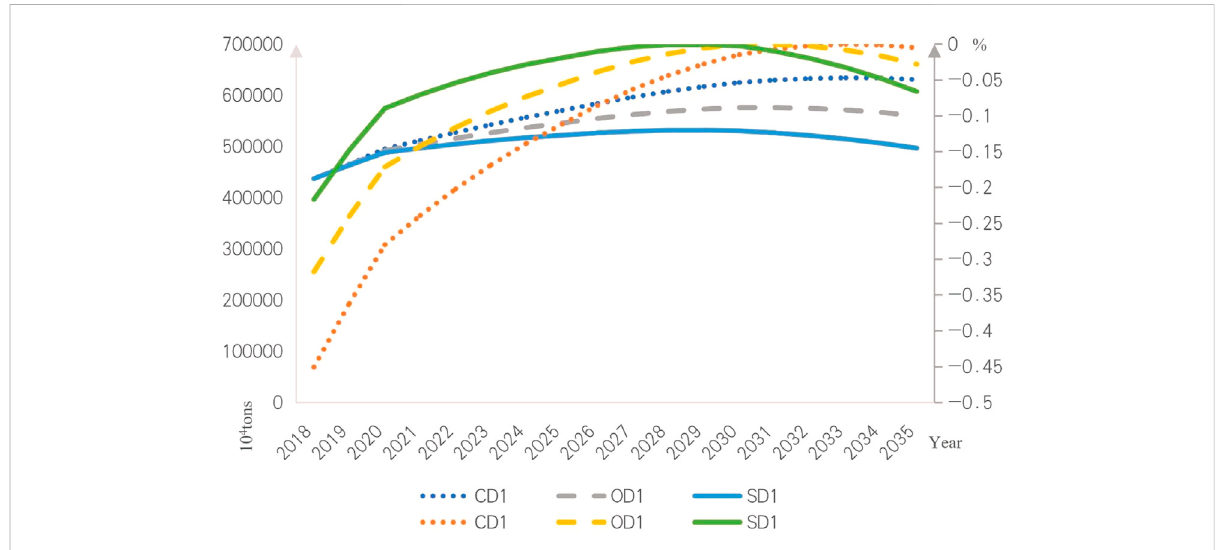
FIGURE 7 Gap between China ’ s coal consumption and peak value under CD1-OD1-SD1 scenario from 2018 to